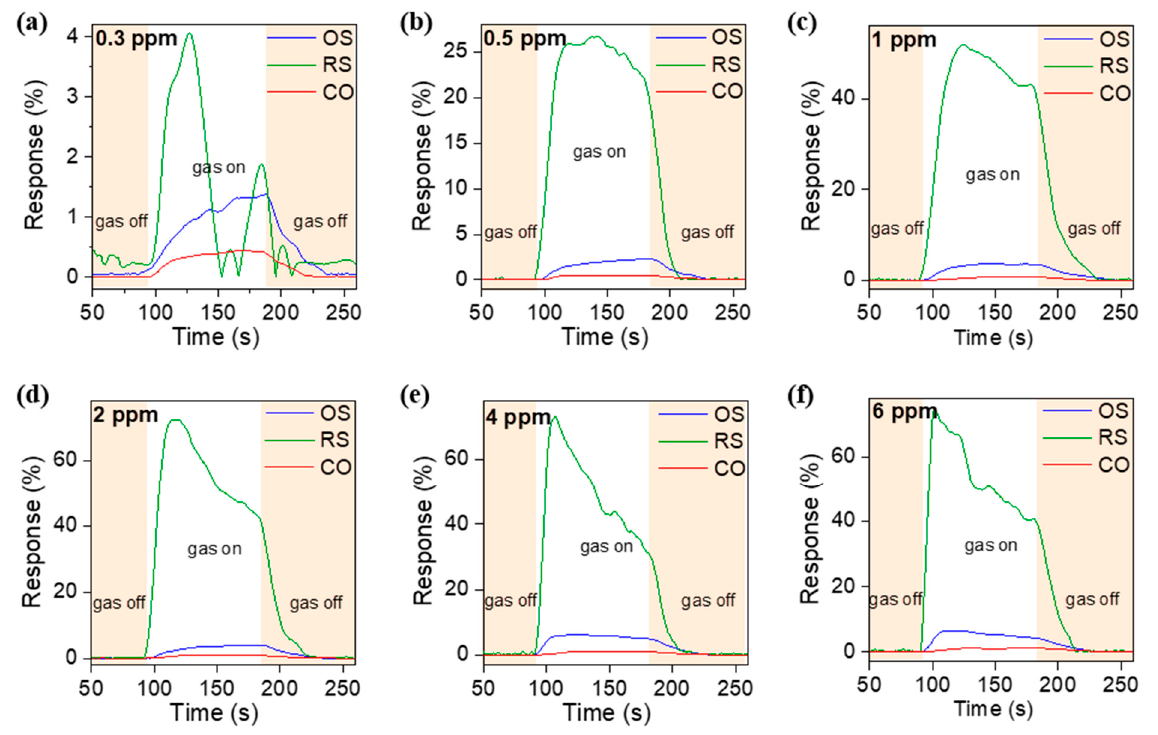
Figure 8. Real-time response–recovery curves of Sn 3 O 4 -RGO gas sensors under different CH 3 COOH concentrations: ( a ) 0.3 ppm, ( b ) 0.5 ppm, ( c ) 1 ppm, ( d ) 2 ppm, ( e ) 4 ppm, and ( f ) 6 ppm.